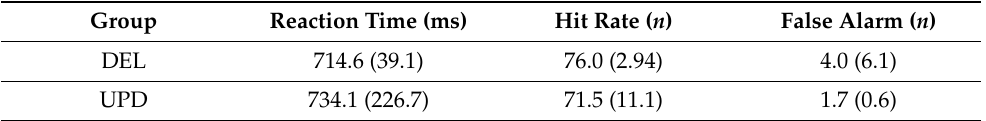
ms = milliseconds; n = number.